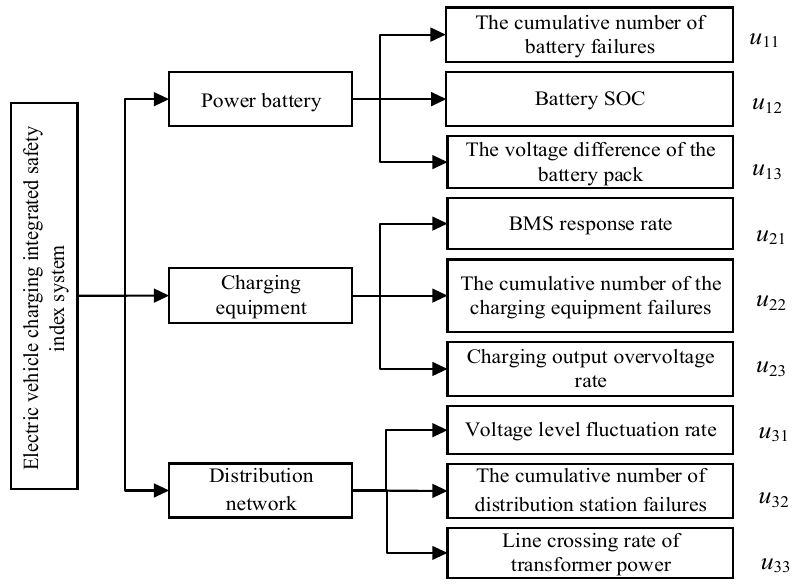
Figure 7. Integrated safety assessment index system for electric vehicles. Ratings are scored for the previously established V = { v 1 , v 2 , v 3 , v 4 , v 5 } rating, which is rated as Table 2.